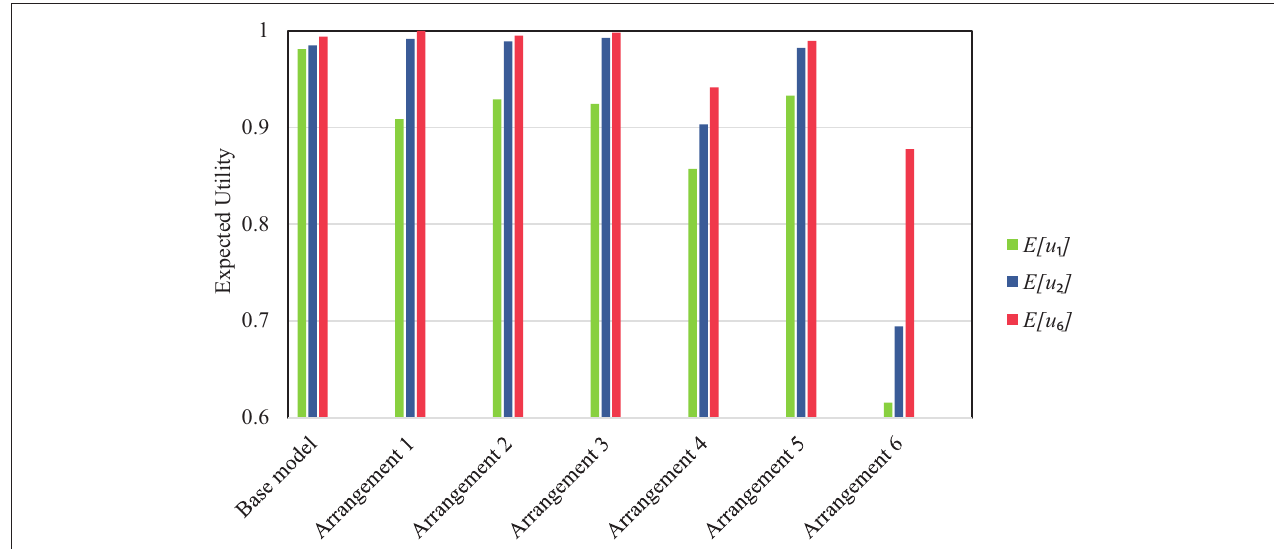
FIGURE 10 | Bar chart of the expected utility for SPSW models.